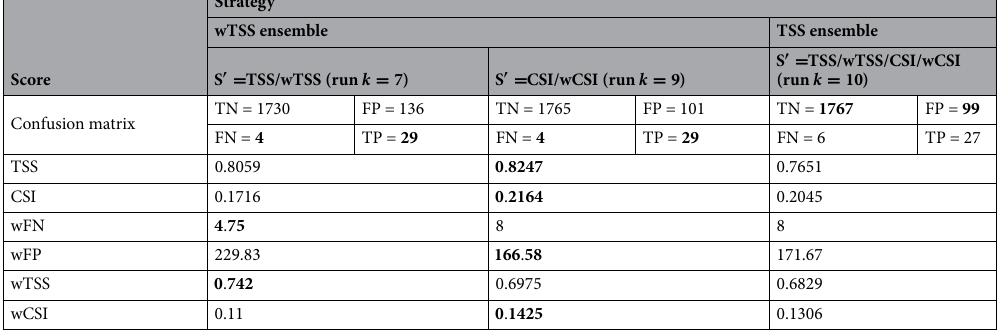
Table 2. Results on the test set obtained by using the wTSS-ensemble strategy when the run is selected with respect to the best TSS or wTSS ( k = 7 run), the wTSS-ensemble strategy when the run is selected with respect to the best CSI or wCSI ( k = 9 run) and the TSS-ensemble strategy when the run is selected with respect to the best TSS or wTSS or CSI or wCSI ( k = 10 run). In bold the best results are